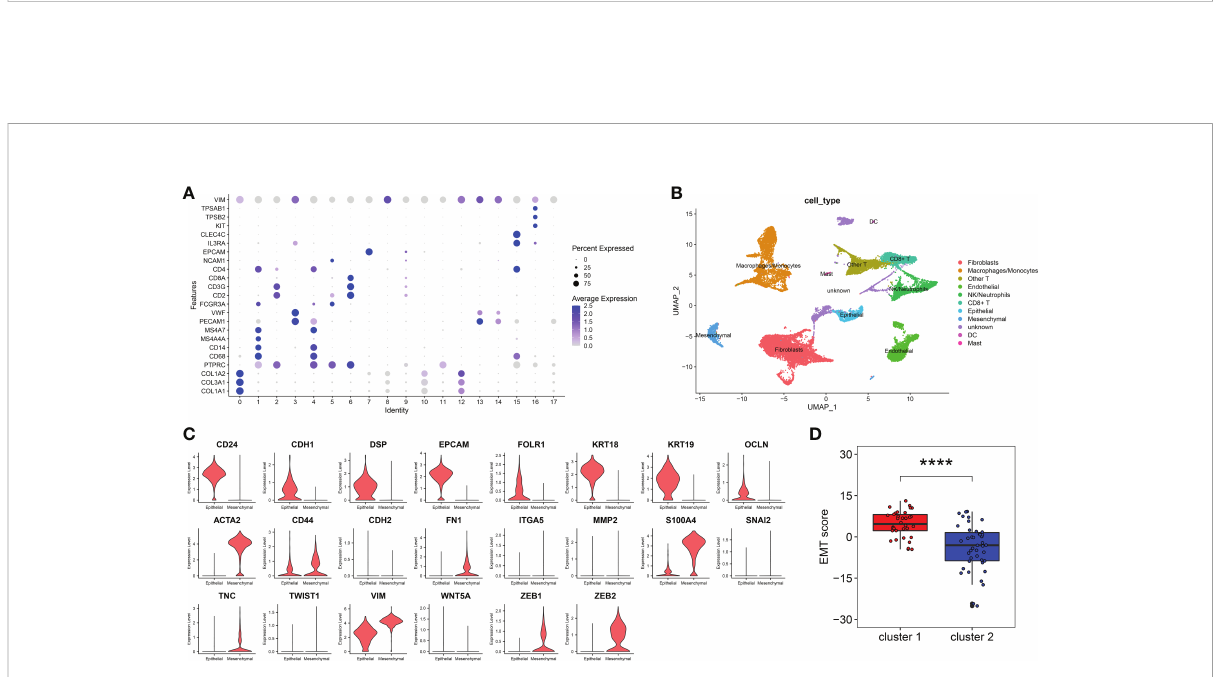
FIGURE 2 EMT score marker genes selection and EMT score calculation. (A) . Marker genes expression of 18 clusters were shown on bubble diagram. (B) . UMAP plots of 11 types of cells. Cells were colored for types. (C) . The expression level of EMT score marker genes in CellMarker website. The upper 8 genes were epithelial cell marker genes and the other 14 genes were mesenchymal cell marker genes. (D) . EMT score of cluster 1 and cluster 2. (p< 0.0001) (****p<